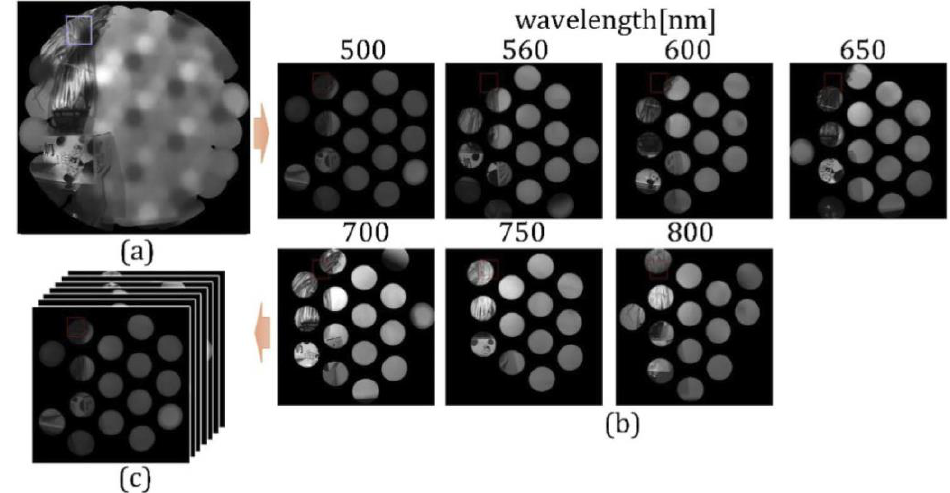
Figure 50. MSI experiment results: ( a ) reconstructed image in the whole FOV, ( b ) reconstructed image for each spectrum channel, ( c ) reconstructed multispectral 3D cube.